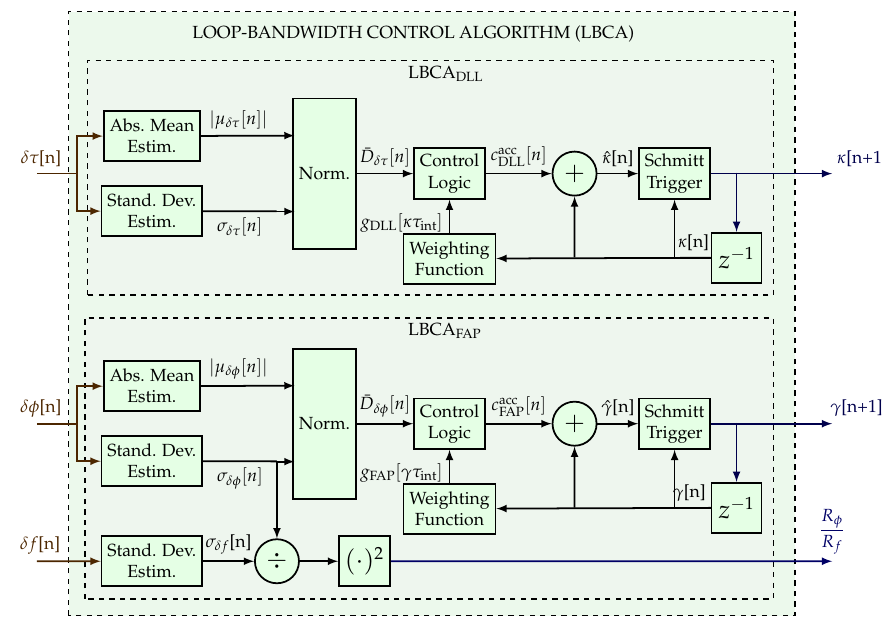
Figure 3. LBCA architecture used in the full LUT-DSKF.